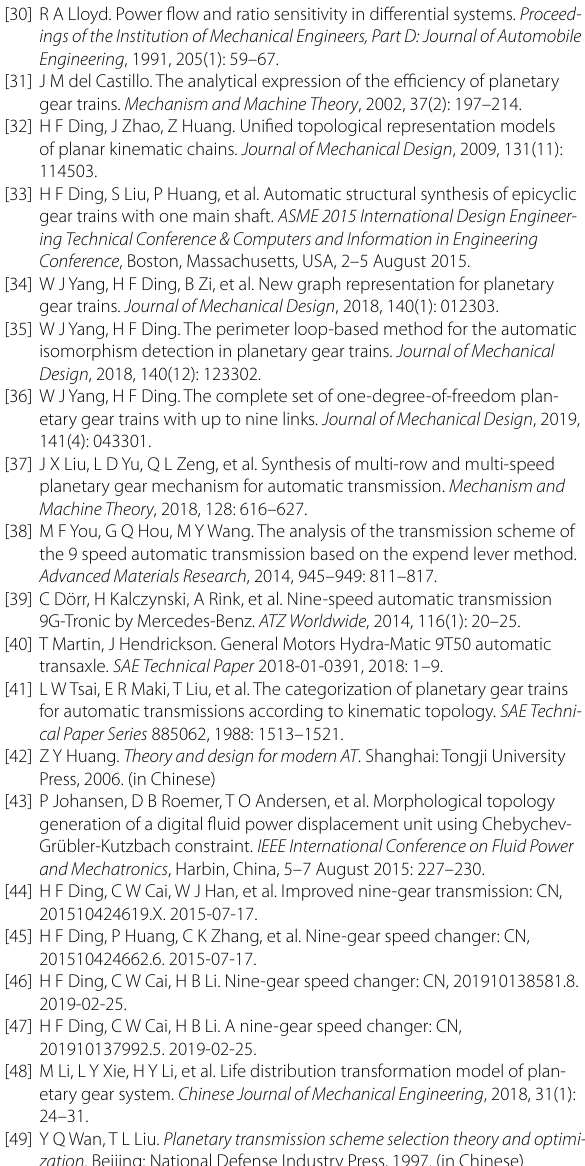
figuration for the dedicated hybrid transmission with multi-degree-of- freedom and multiplanetary gear set. Journal of Mechanical Design ,